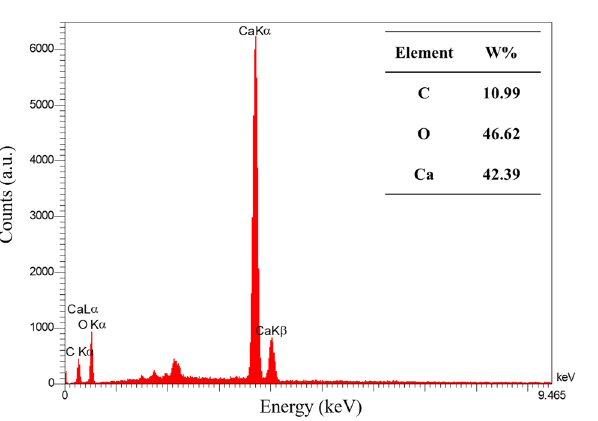
Figure 16. EDX analysis of the film covering the grains in the samples treated with formate-based